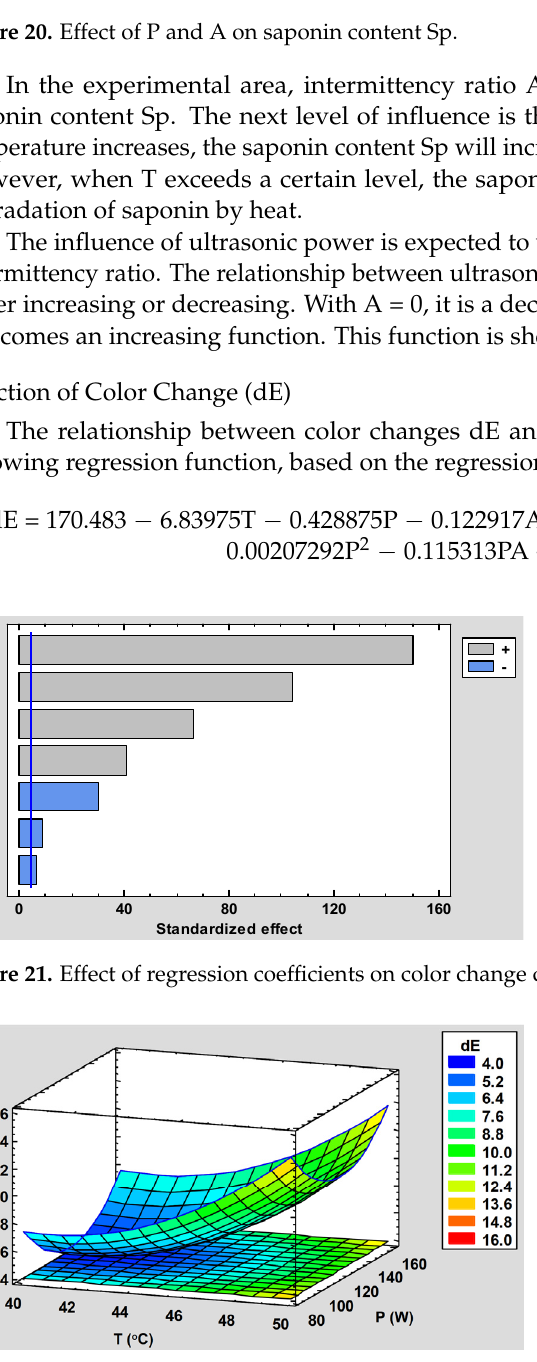
Figure 20. Effect of P and A on saponin content Sp.